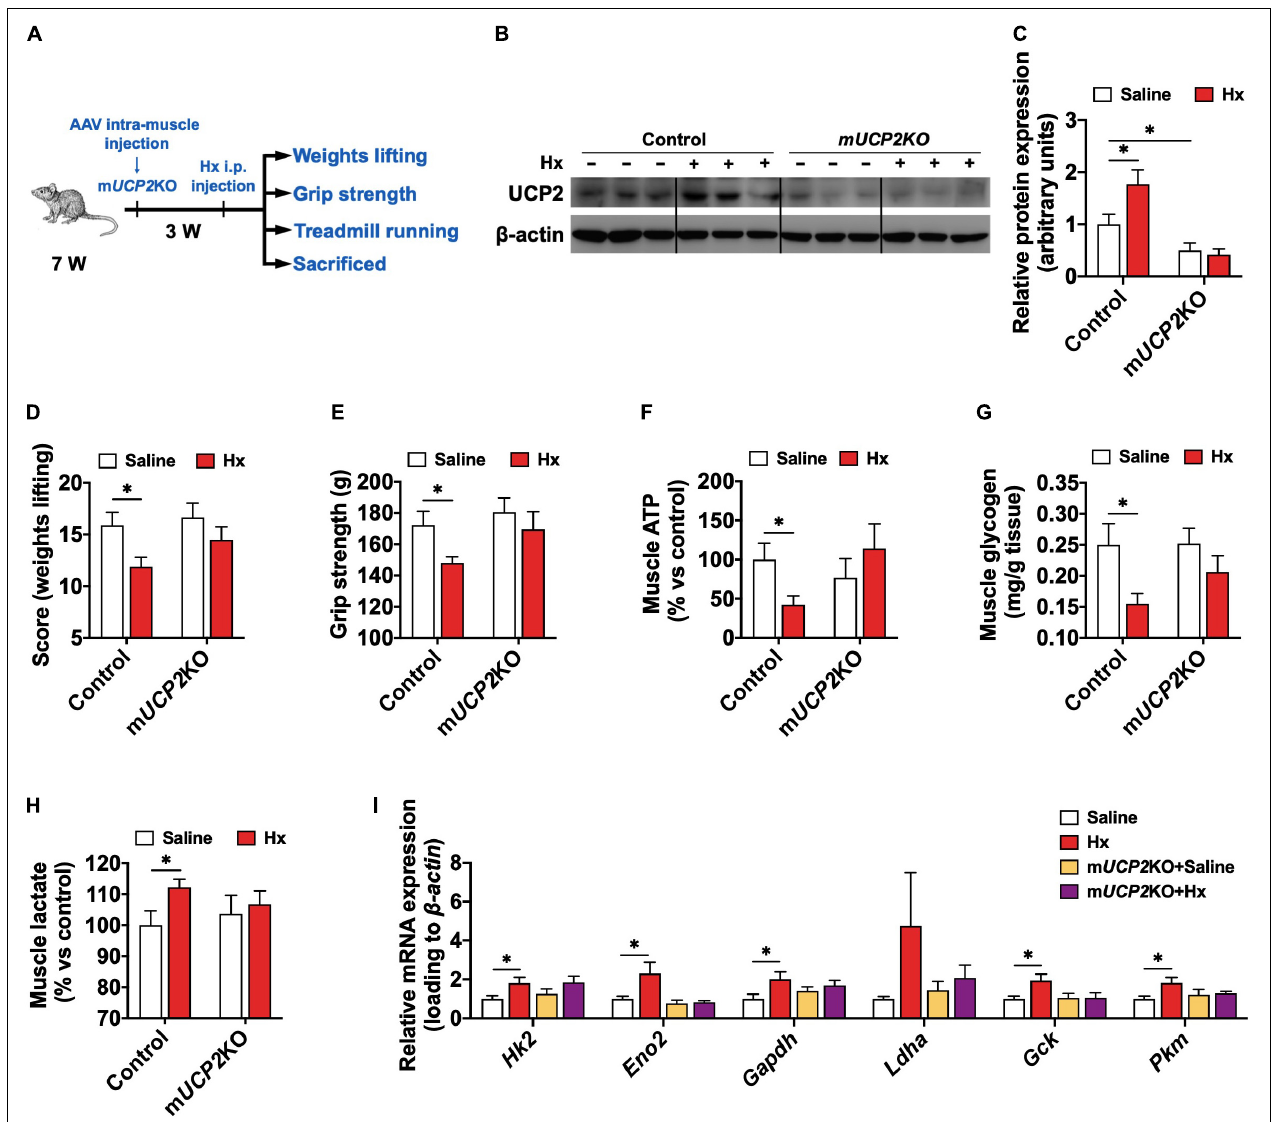
FIGURE 6 | UCP2 is required for the Hx-induced muscular ATP deficiency and weakness. (A) Experimental scheme for the acute Hx treatment on m UCP2 KO mice. (B,C) Western blot (B) and quantification (C) of UCP2 content in the GAS muscle after acute Hx treatment ( n = 6 per group). Dividing lines indicate spliced bands from the same gel. (D) Weights lifting score after acute Hx treatment ( n = 8 mice per group). (E) Grip strength after acute Hx treatment ( n = 8 mice per group). (F–H) GAS muscle ATP (F) , glycogen (G) , and lactate (H) content of mice after acute Hx treatment ( n = 7–8 mice per group). (I) mRNA expression of genes related to the glycolysis of GAS muscle after acute Hx treatment ( n = 7–8 mice per group). β -actin was used as loading control both in qRT-PCR and western blot. Values are presented as means ± SEM; ∗ P ≤ 0.05 according to the non-paired Student’s t -test between individual